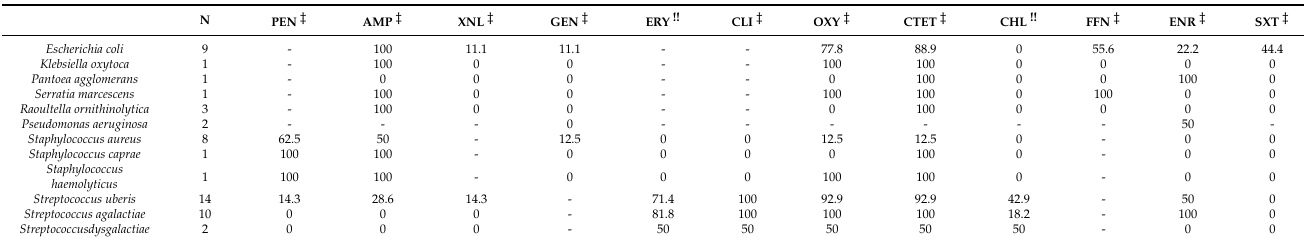
Table 2. Percentage of resistant Enterobacterales , Pseudomonas spp., Staphylococcus spp., and Streptococcus spp. isolates recovered from milk samples with bovine and caprine mastitis